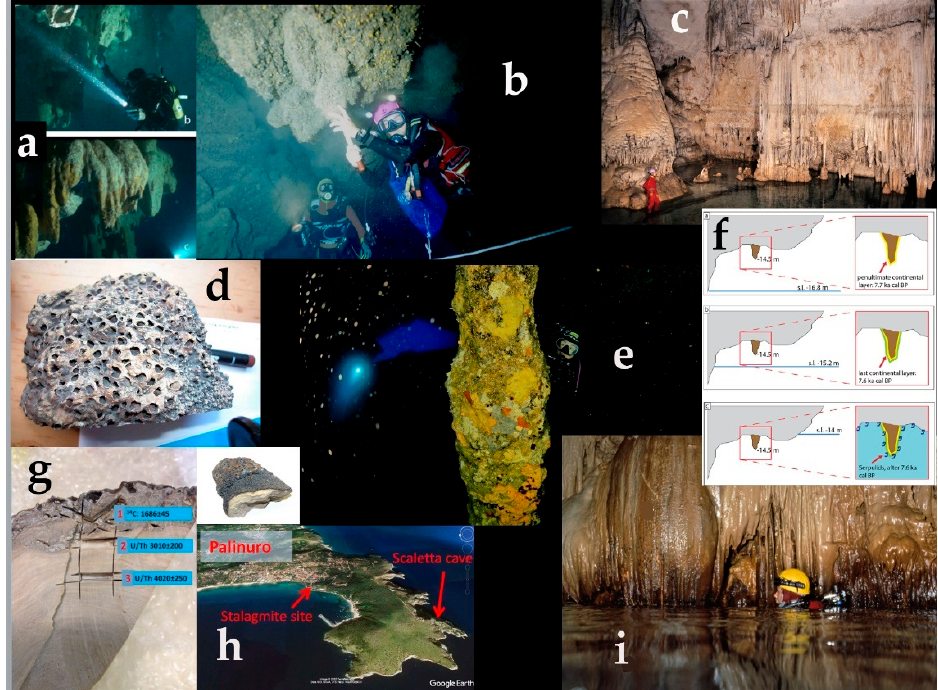
Figure 2. Coastal caves and submerged speleothems in Italy and Malta. ( a ) Stalactites sampled at − 14 m in Malta. ( b ) Sampling survey conducted at − 41 m in the Scale tt a cave (Palinuro) by F. Antonioli, L. Ferranti, and M. Oliverio. ( c ) Oxidation bands observed at +4 m in the Nettuno cave and phreatic speleothems (photo by Mauro Mucedda). ( d , e ) Stalagmite collected in Palinuro encrusted by specimens of the barnacle Chthamalus . Cross section of the sample showing the portions collected for 14 C and U-series disequilibrium dating. ( f ) Cattedrale cave (Marettimo Island). ( g ) Growth model of the stalactite sampled in the Gebel Ciantar cave in Malta [65]. ( h ) Photo of the Palinuro promontory with the sampling sites of Scaletta cave and the stalagmite with barnacle overgrowth. ( i ) Risorgenza di Cala Luna cave. Photo by F. Antonioli.